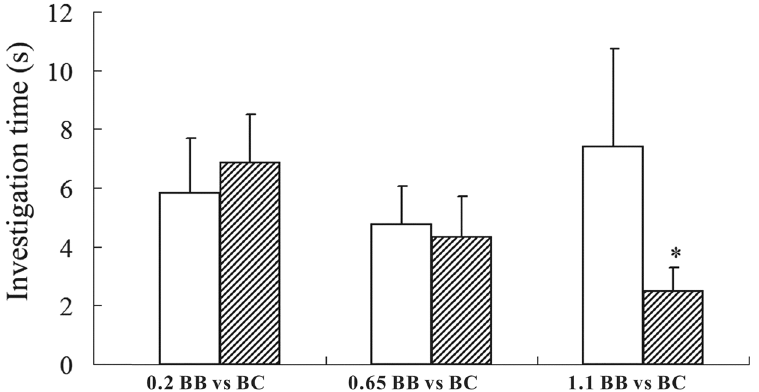
Figure 6. Responses of female C57BL/6 to BC and BB male urine with different levels of recombinant darcin added. In each test, mice were presented with two urine samples from BB (white bars), BC (diagonal hatched bars). Values before BB refer to the concentration of recombinant darcin added ( μ g/ μ L). * Indicates a significant ( P < 0.05) difference between the investigation times in each trial. The data are presented as mean ± SE, n = 12 in each group. BB: BALB/c strain; BC: hybrid of BALB ♀ × C57 ♂